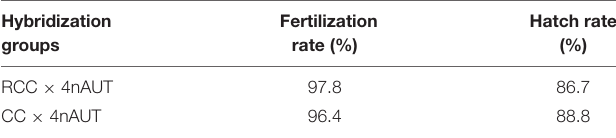
TABLE 1 | Fertilization rate and hatch rate of the two groups. Hybridization groups